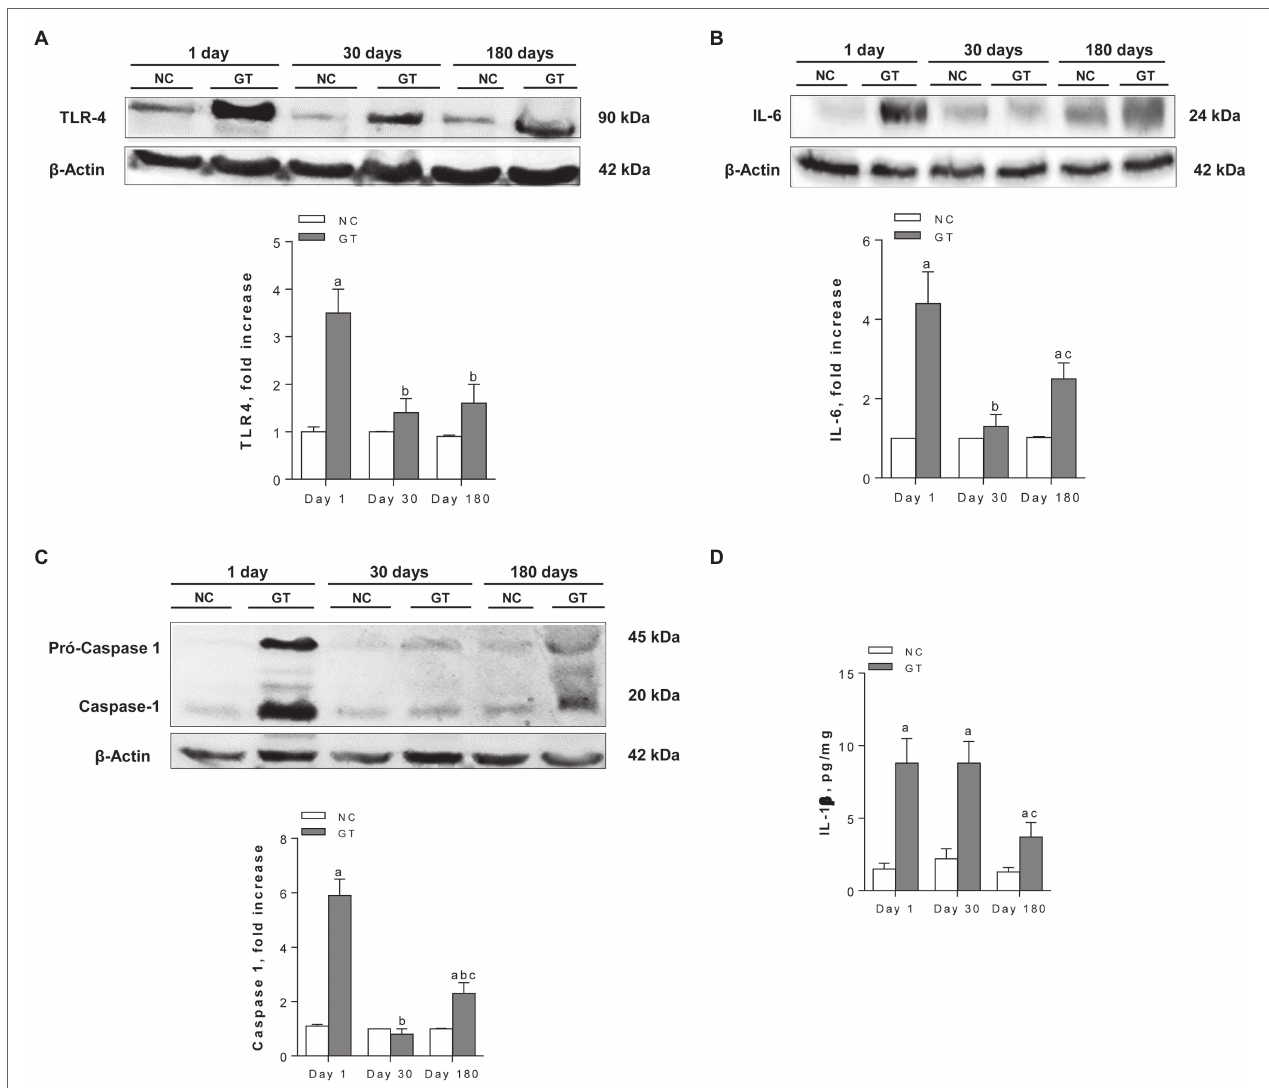
FIGURE 6 | Representative Western blots and quantitative assessment of the abundance of Toll-like receptor 4 (A) , Interleukin-6 (B) , Caspase-1 (C) , and renal content of IL-1 β by ELISA (D) in groups NC and GT on Days 1, 30, and 180. Western blot analysis included seven animals per group. Results expressed as means ± SE . a p < 0.05 vs. NC, b p < 0.05 vs. Day 1, and c p < 0.05 vs. Day